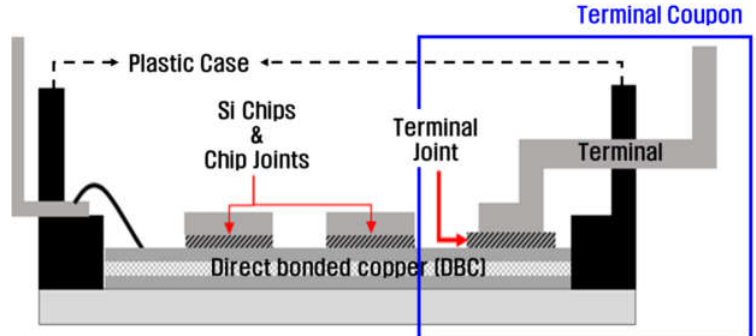
Figure 1. Schematic diagram of power module showing the terminal joint.